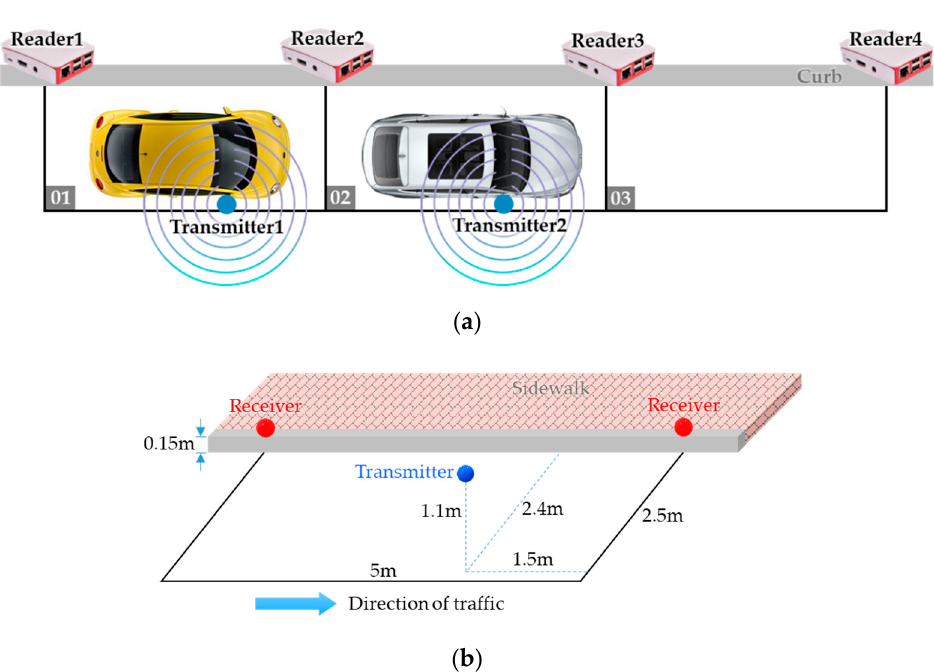
Figure 11. Experiment 2: ( a ) test scenario, ( b ) detailed deployment within each parking space.